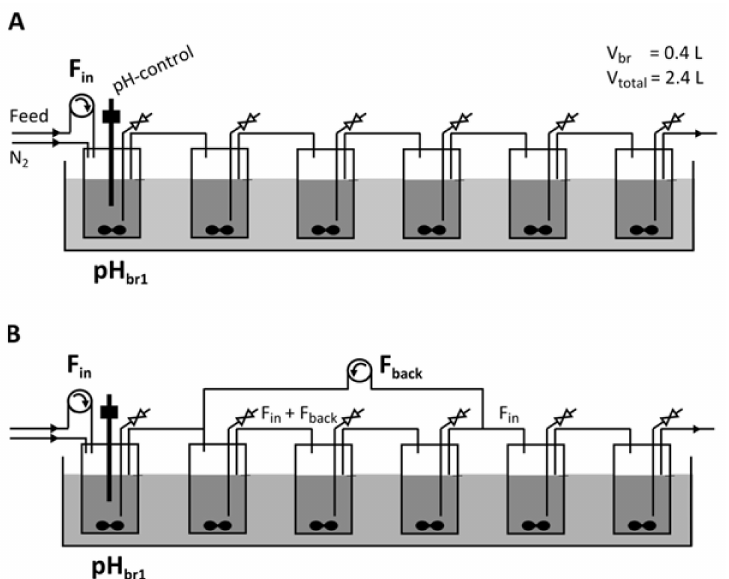
Figure 1. Set-up of the linear bioreactor cascade ( A ) and the cascade with feedback loop ( B